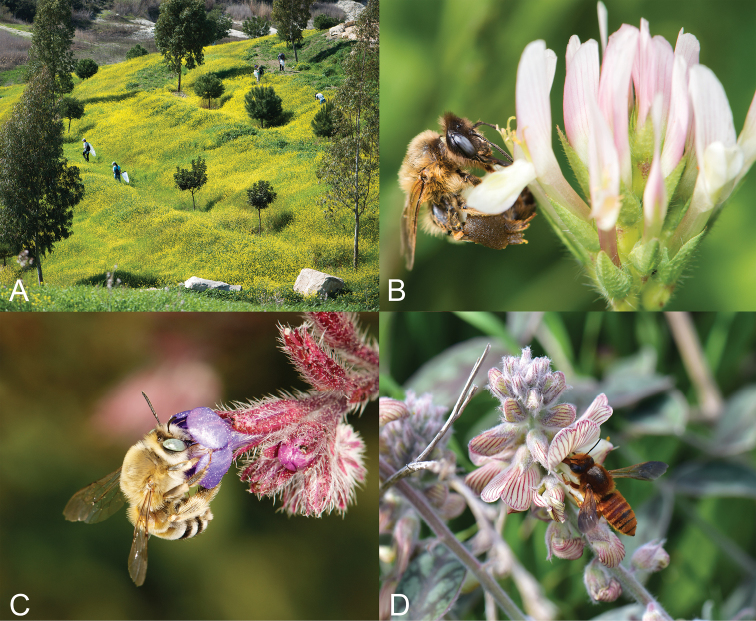
A Landscape with diverse bee fauna in Cyprus (Yermasoyia Dam area) BMelitturga
syriaca foraging on Trifolium
clypeatumCEucera
dimidiata foraging on Anchusa
undulata
subsp.
hybridaDMegachile
cypricola foraging on Onobrychis
venosa. Pictures provided by Nicolas J. Vereecken (A, B, C) and Androulla Varnava (D).